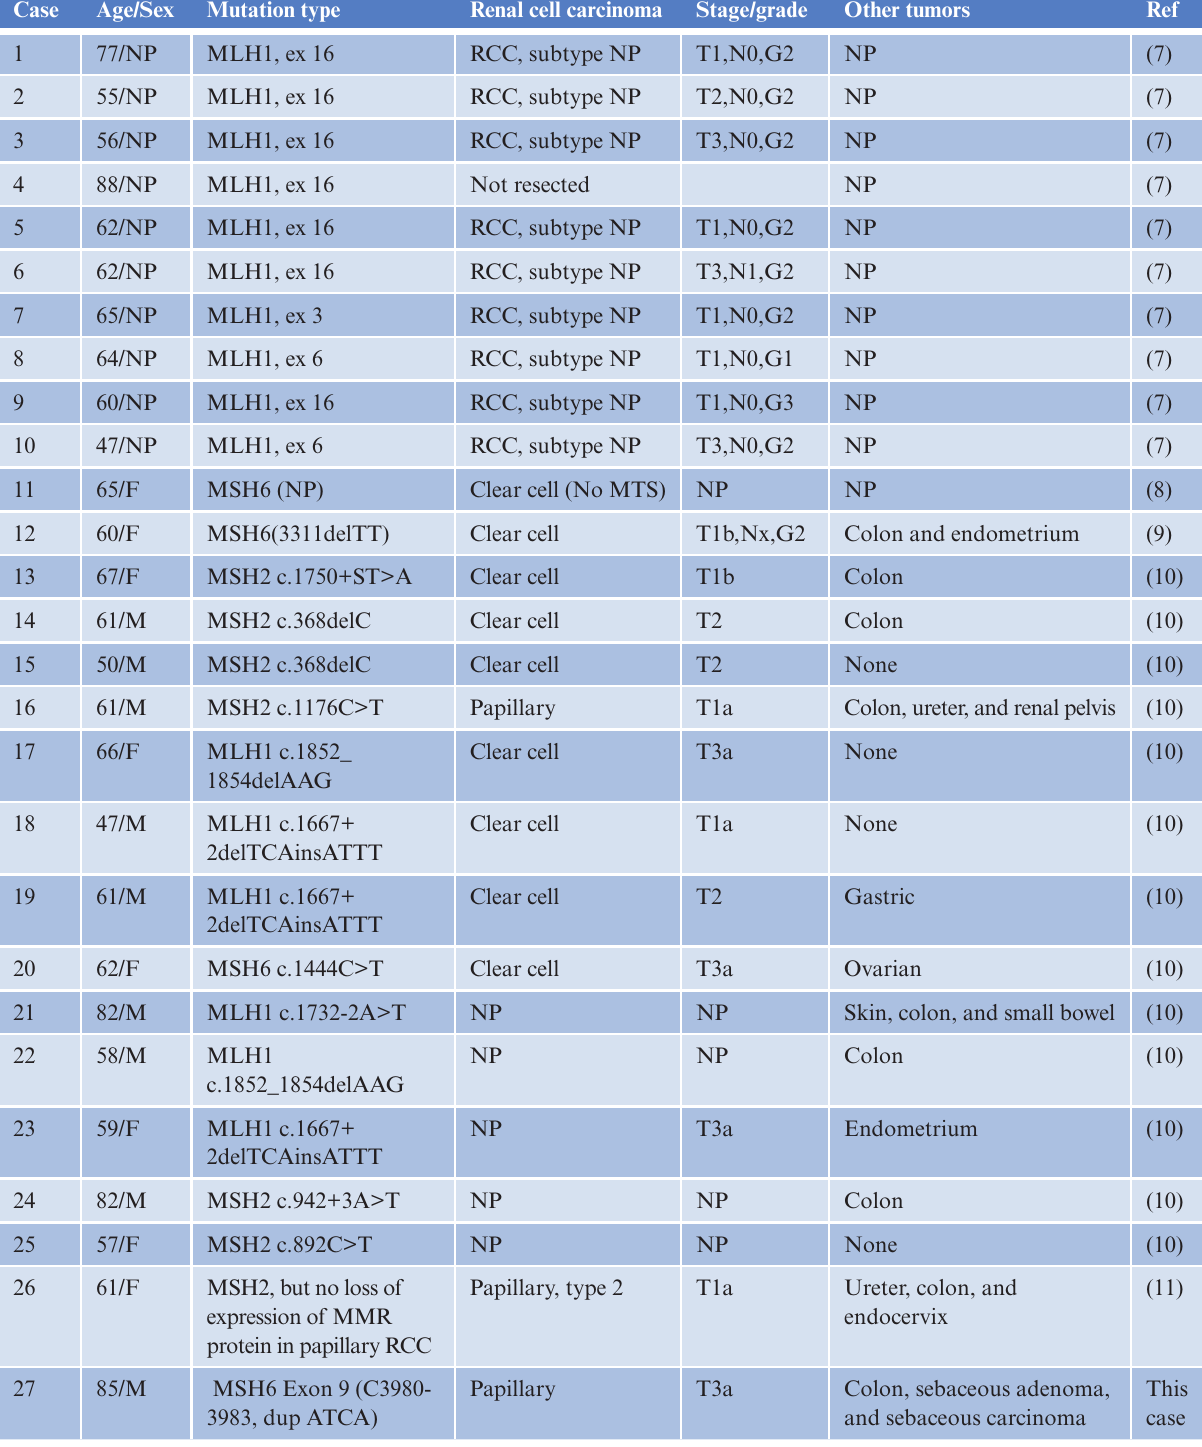
Table 2: Reported cases of renal cell carcinoma in Lynch